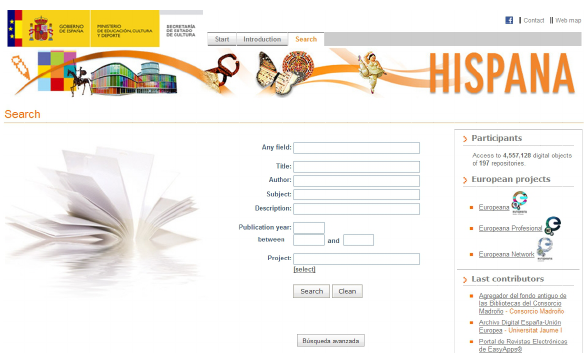
Figure 8. Searching cultural content by means of HISPANA